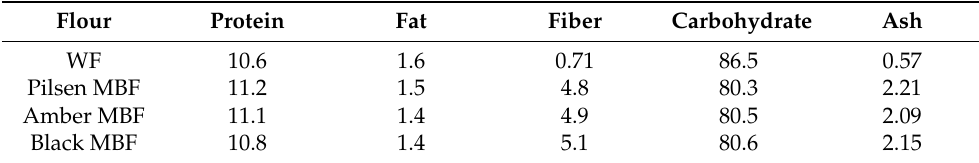
Table 3. Proximate composition of wheat flour (WF) and malted barley flour (MBF) (g/100 g d.m.). Flour Protein Fat Fiber Carbohydrate Ash WF 10.6 1.6 0.71 86.5 0.57 Pilsen MBF 11.2 1.5 Amber MBF 11.1 Black